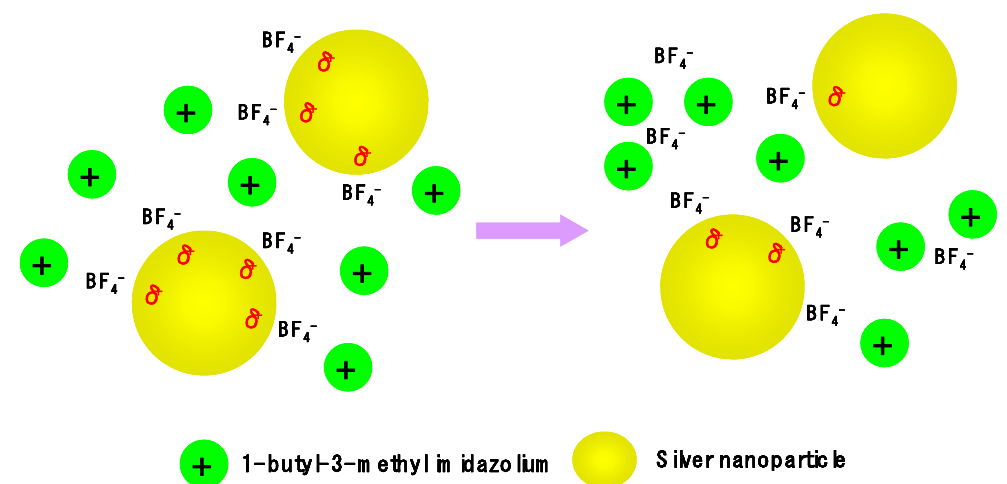
Scheme 1. Ag nanoparticles in ionic liquid BMIMBF 4 with time.